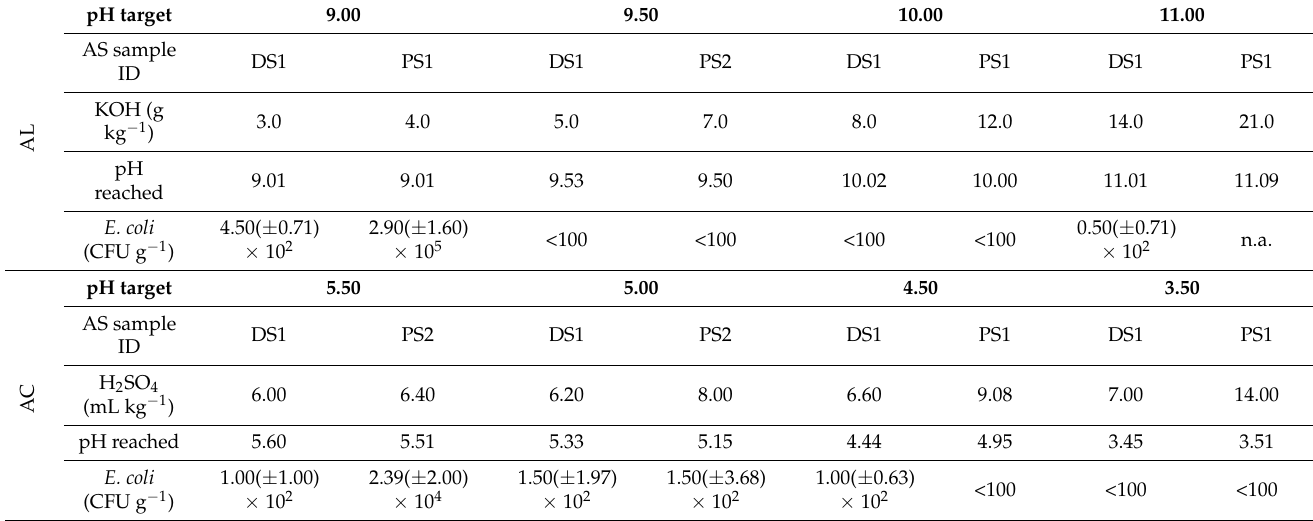
Table 3. Doses (g kg − 1 slurry) of potassium hydroxide (KOH) used to increase the pH of dairy and pig slurries to the target pH values (9.00; 9.50; 10.00; and 11.00), and E. coli (CFU g − 1 ), before and after alkalinization of the slurry samples; and doses (mL kg − 1 slurry) of concentrated sulphuric acid (H 2 SO 4 ) used to decrease the pH of dairy and pig slurries to the target pH values (5.50; 5.00; 4.50 and 3.50), and E. coli (CFU g − 1 ) before and after acidification of the slurry samples (Mean, n =